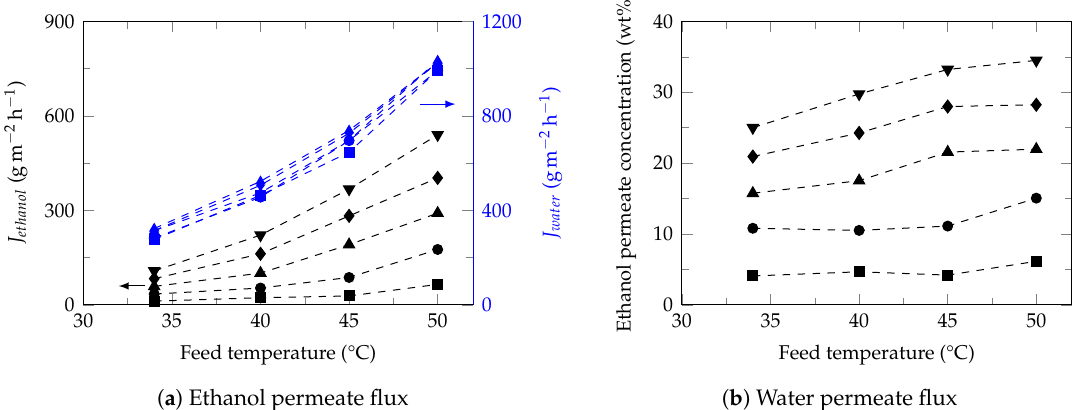
Figure 5. Effect of feed temperature on the ethanol (black) and water (blue) fluxes. Ethanol feed concentrations: 1wt% ( (cid:4) ), 3wt% (